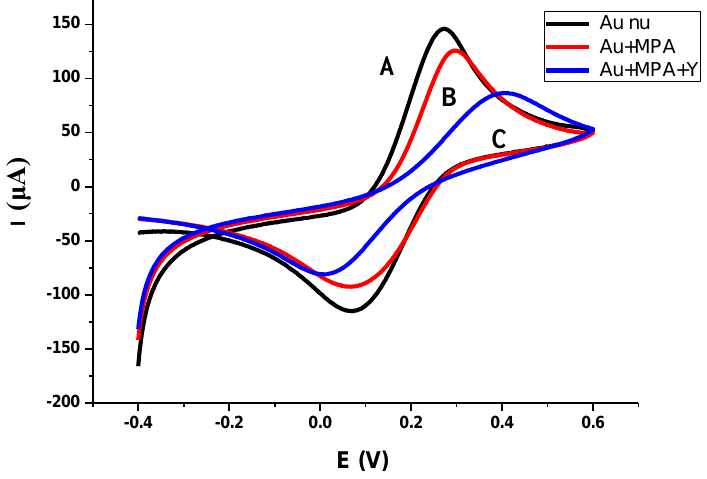
) 3–/4– as the redox probe 6